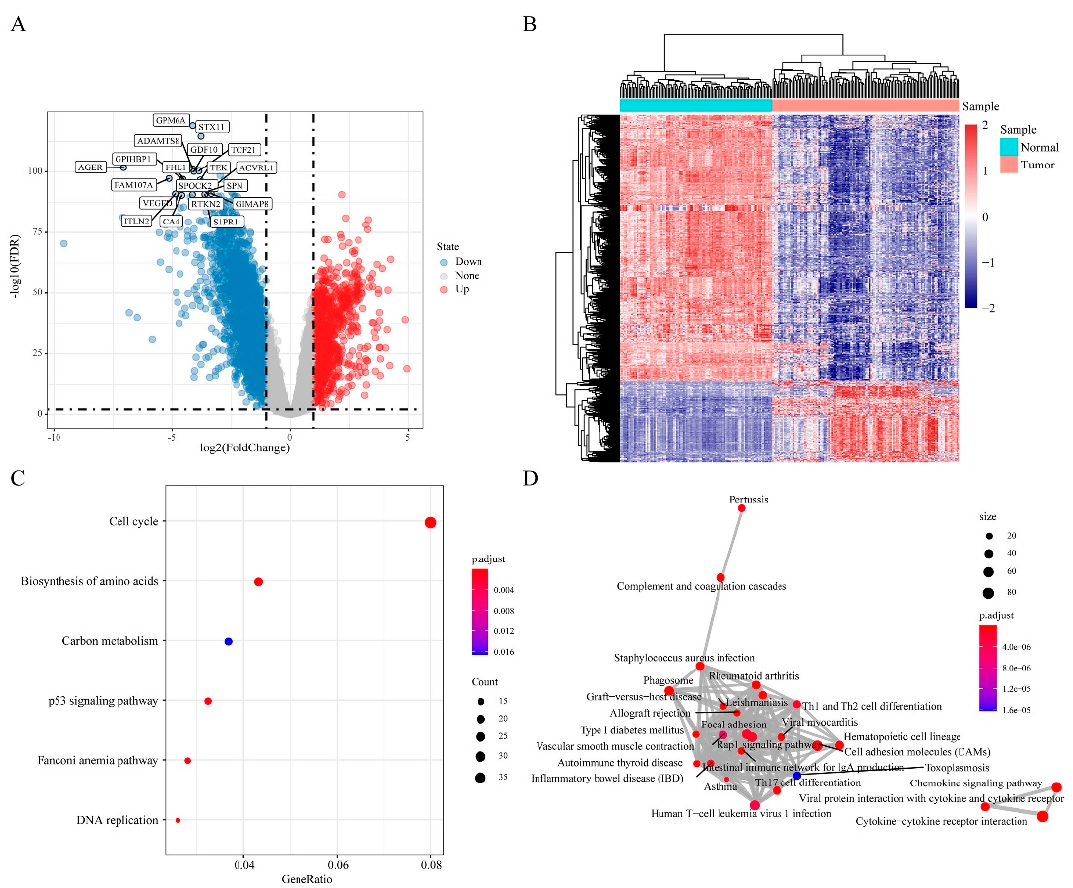
Figure 3. Differentially expressed genes (DEGs) in “EGFR Wild Type/Low PD-L1 expression” NSCLC. ( A ) Volcano plot showing the distribution of DEGs. ( B ) Heat map and hierarchical clustering analysis of DEG. ( C ) Significantly enriched KEGG categories show differentially up-regulated genes. ( D ) Significantly enriched KEGG categories show differentially down-regulated genes. The size of the dots represents the number of genes enriched in the pathway, and the colors correspond to different FDR values. The lines represent the intersection of genes between pathways.